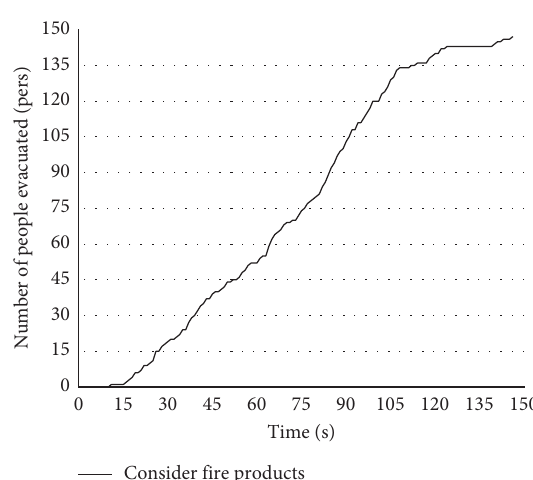
Figure 30: Exit 4 evacuation